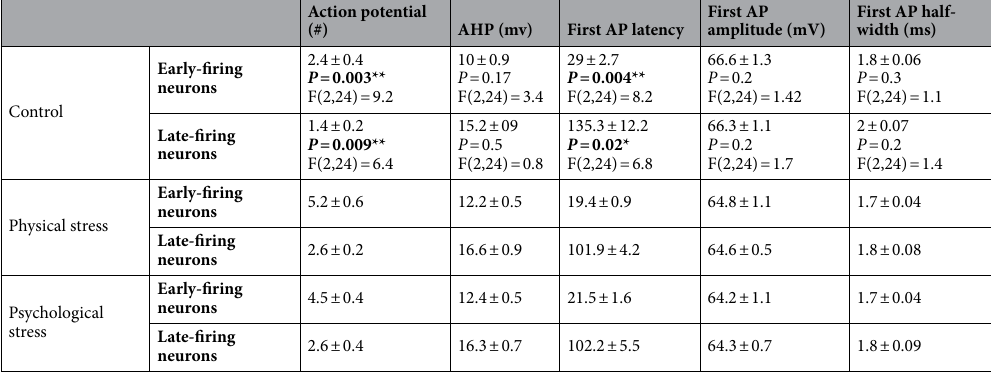
Table 2. Electrophysiological properties of early- and late-firing neurons. AHP = Afterhyperpolarization. Data are represented as Mean ± SEM. * ( p < 0.05), ** ( p < 0.01) within groups. Significant values are in bold.